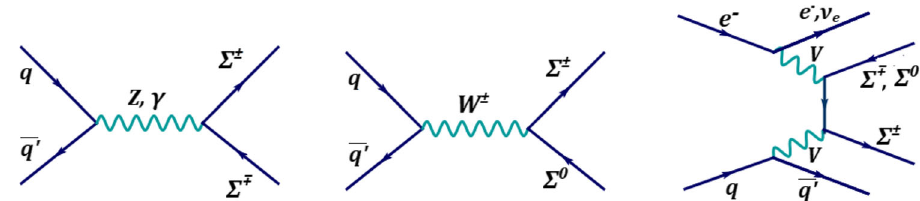
Fig. 3 Representative Feynman diagrams for the production of (cid:2) ± and (cid:2) 0 at colliders